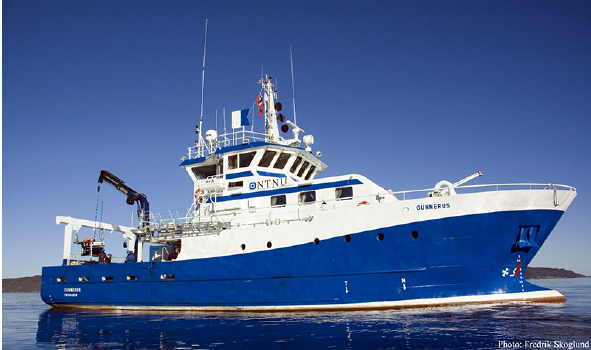
Figure 3: Starboard view of the RV Gunnerus.